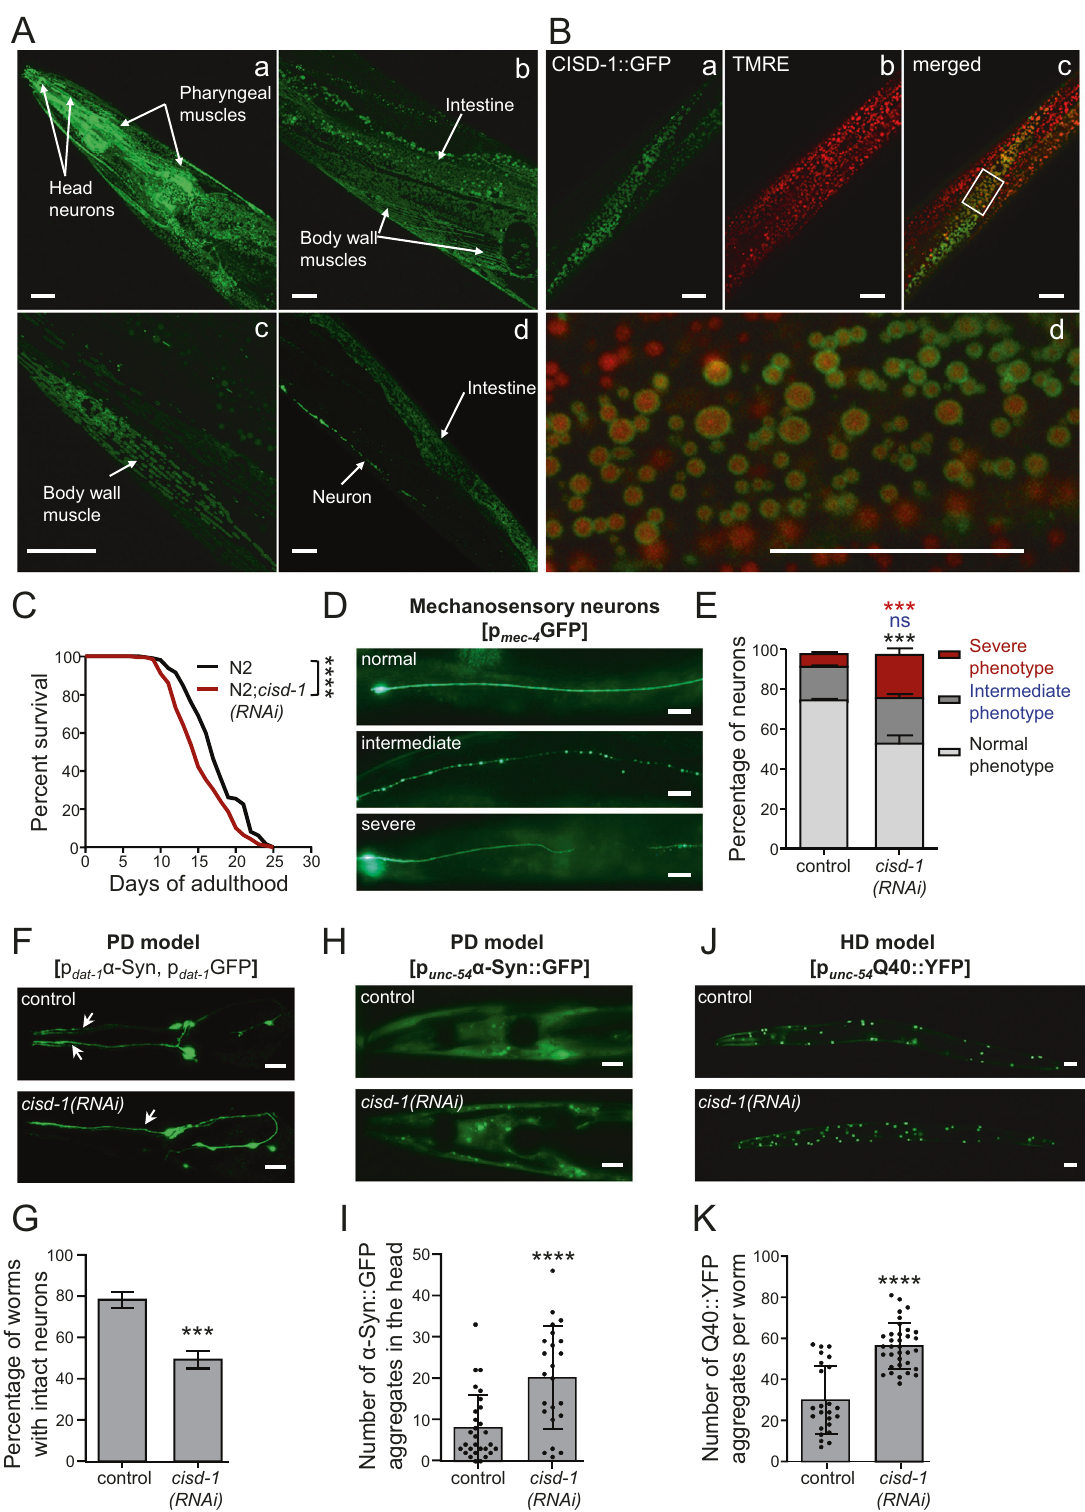
[1]. Hence, we investigated the role of key electron transport chain (ETC) proteins in CISD-1-dependent longevity. Disruption of mitochondrial function in C. elegans leads to severe consequences, such as cell death and organismal senescence. Paradoxically, hypomorphic mutations in speci fi c ETC components lead